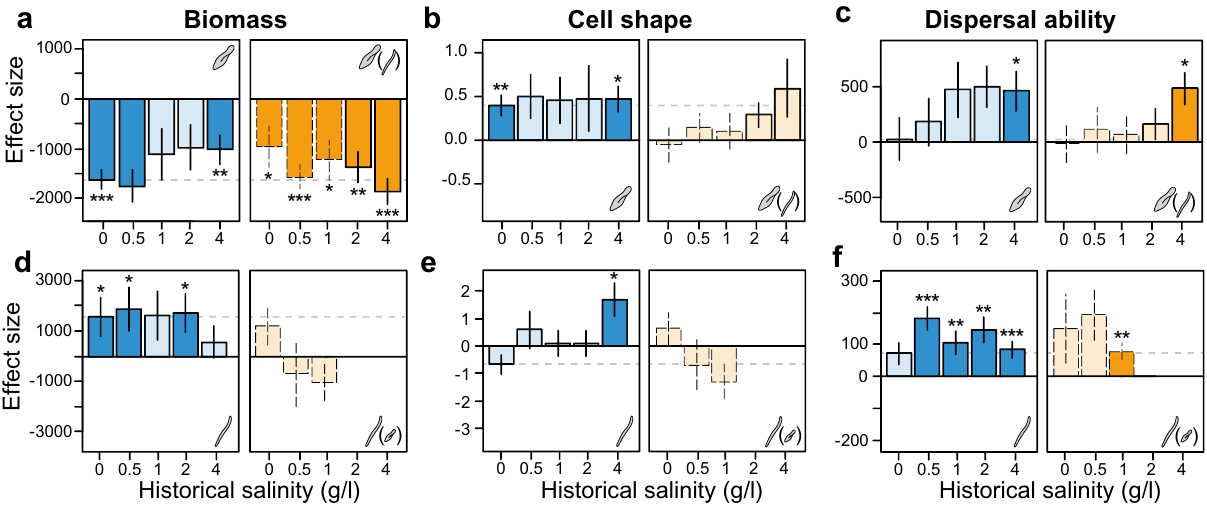
Figure 4. Genetic contributions to phenotypic change along the different salinity conditions and in function of competition. Bars display the magnitude (i.e. effect size) of the genetic responses to salinity and their standard errors for Paramecium aurelia ( a–c ) and Spirostomum teres ( d–f ) evolved in the absence (blue colors) and presence (orange colors) of competing species for ( a , d ) biomass, quantified as bio-area, ( b , e ) cell shape, quantified as cell size ratio between the major and minor cell axis, and ( c , f ) dispersal ability, quantified as gross speed. For the competition treatment, only the P. aurelia populations evolved in the two highest salinity conditions reflect accurate estimates for genetic trait change in this analysis. In the lowest salinity conditions this component is confounded with a plasticity response to the presence of competing species (indicated by dashed bars). Darker colors indicate significant effects, with asterisks referring to the level of significance; *< 0.05, **< 0.01, ***< 0.001. Detailed partitioning into (ancestral) plasticity, mean trait evolution and evolution of plasticity can be found in Supplementary Figs. S5–S6. Summary of statistical results can be found in Tables S7and